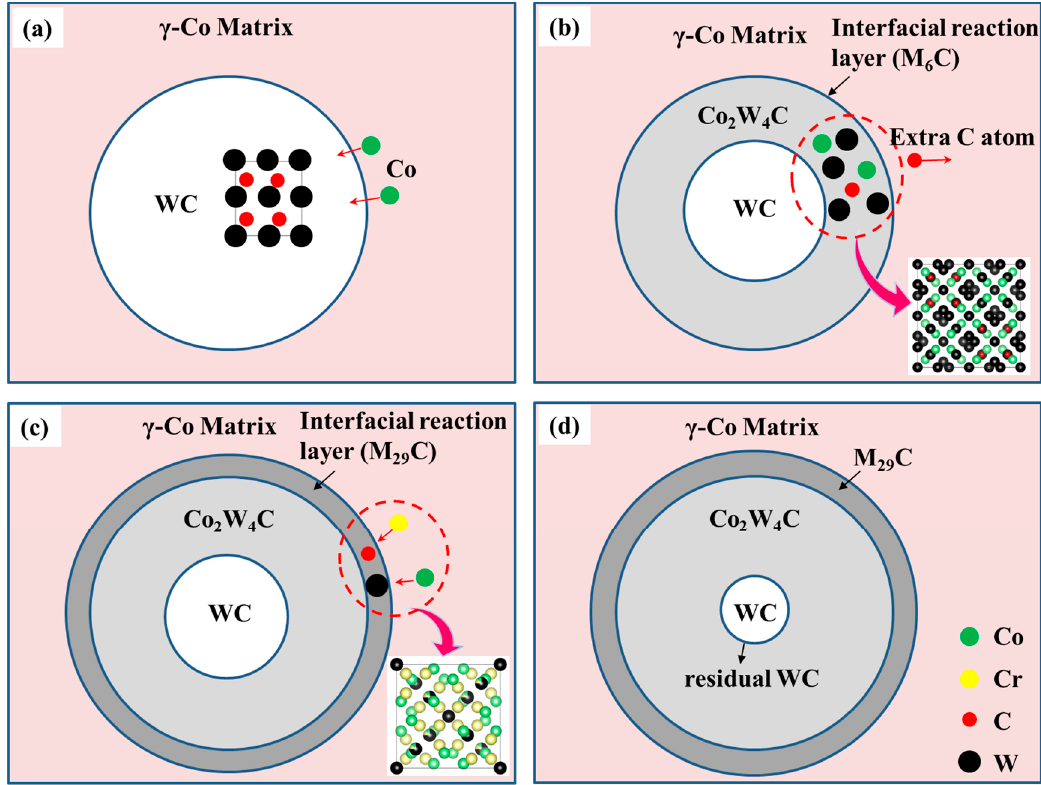
Figure 10. Schematic showing the formation mechanism of carbides in the Co–Cr–W matrix composites. ( a ) Diffusion of Co atoms to the added WC; ( b ) reaction of the Co with the WC and formation of the M 6 C; ( c ) the reaction remaining C atoms diffuse into the matrix and react with the W, Cr and Co atoms to form the M 29 C; ( d ) underreaction of the WC lead to the formation of the residual WC in the M 6